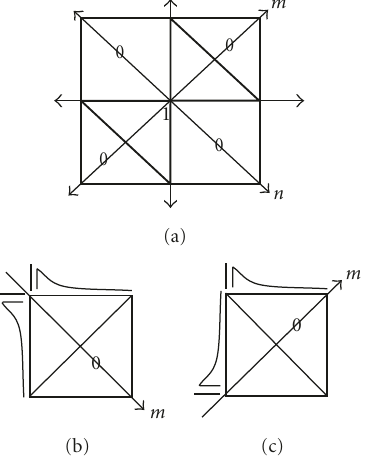
Figure 1: (a) 45-degree tilted form of the kernel with zeros filled in to form the centrosymmetric matrix (cid:11) Ψ , (b) eigensystem decom- position of 90-degree rotated right upper quadrant of the kernel matrix, corresponding to matrix R , with cartoon eigenvectors and the impulse function (Step 2 in the algorithm), and (c) synthesis by rotating back corresponding to Step 3 in the